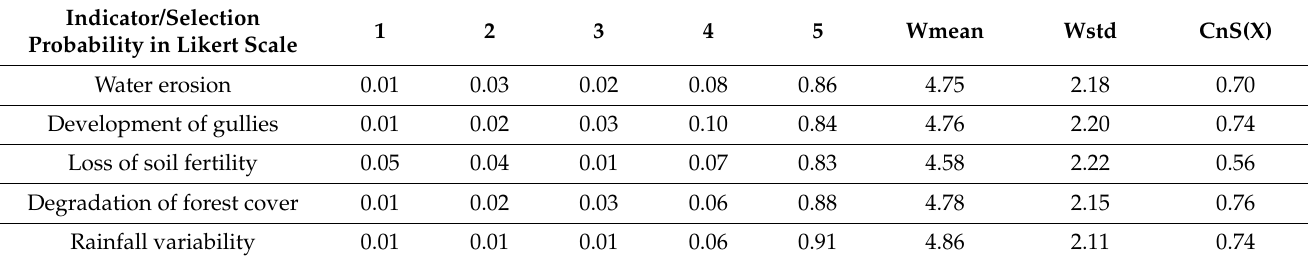
Table 8. States perceived by households due to land use/land cover changes.